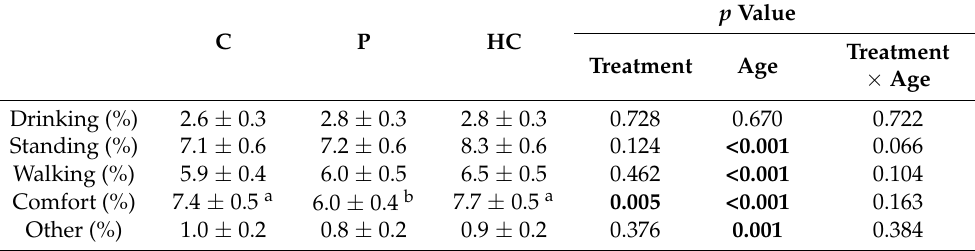
Table 2. Mean proportion of time ( ± SEM) spent drinking, standing, walking and performing comfort or other behaviors for birds that were raised under standard conditions (C); with physical items (P); or with additional human contact (HC). Differing superscript indicates a significant difference at p < 0.05 between treatment groups. Bold font indicates significant p -values at p < 0.05. p Value C P HC Treatment Treatment Age × Age Drinking